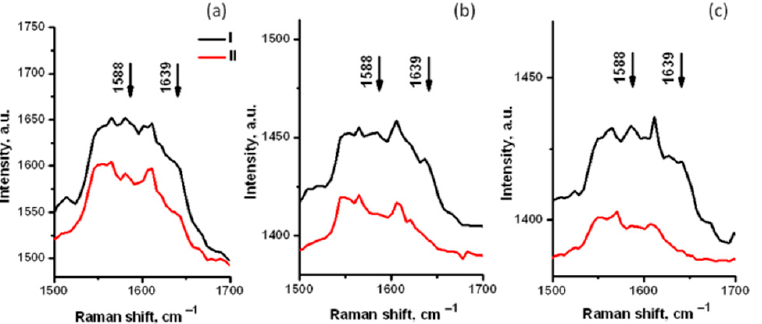
Figure 5. Characteristic Raman spectra measured in the most oxygenated and in the most deoxygenated areas of an individual RBC: (a) control; (b) RBC treated with TiO 2 (r); and (c) RBC treated with TiO 2 (a). Spectra are extended in the 1500–1700 cm − 1 range; oxygenation state marker bands are shown. For every RBC, the spectra demonstrate higher (I) and lower (II) oxygenation states.